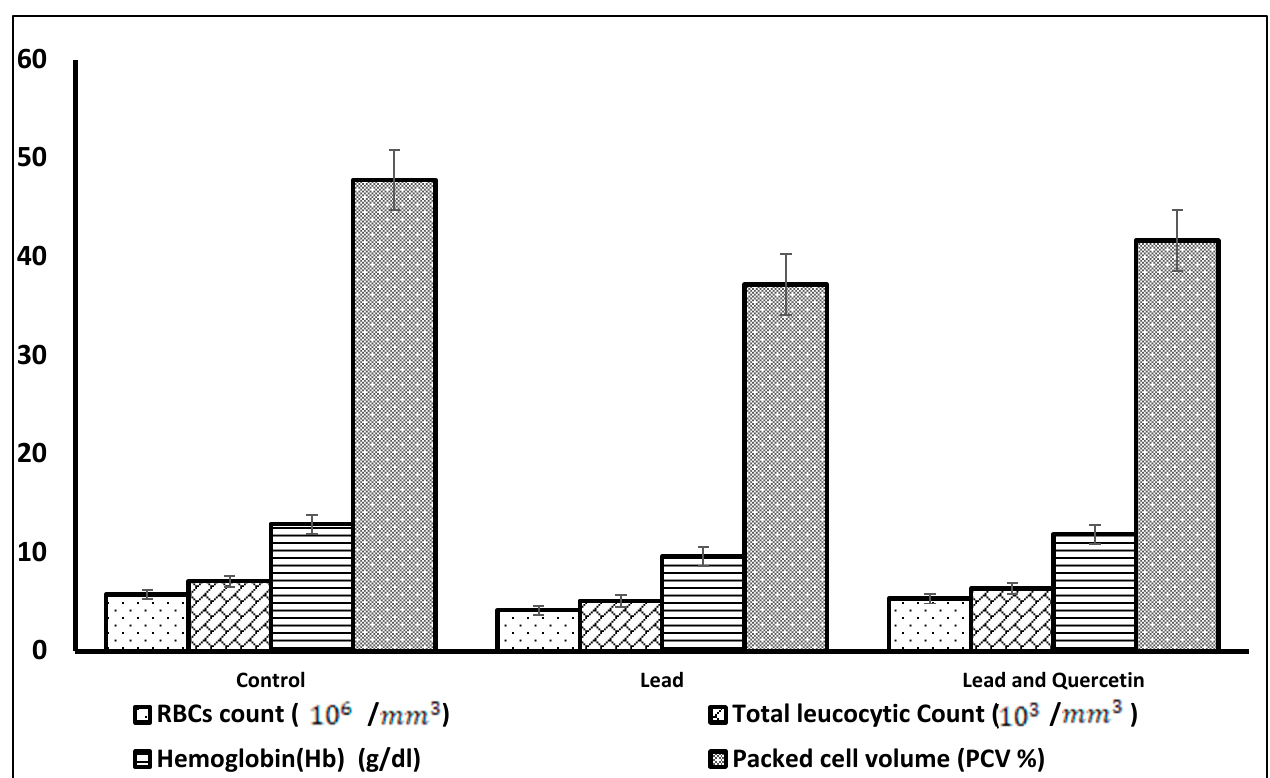
Figure 1. Hematological parameters in rats exposed to lead, and rats exposed to lead and given quercetin phytosome, compared to the untreated control rats.